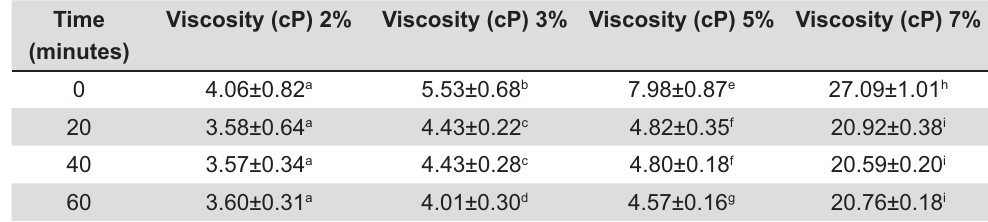
Table 4- Effect of time on the viscosity of pasteurized human milk thickened maintained at Time